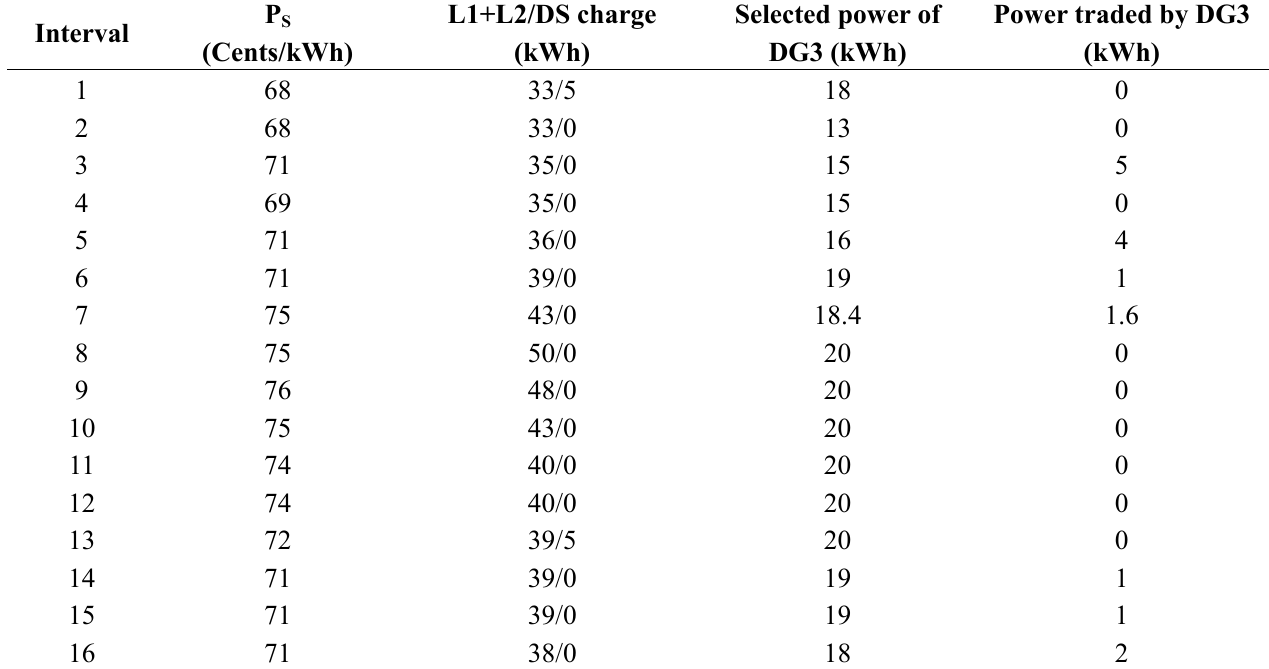
Table 4. Behavior of DG3 in 24